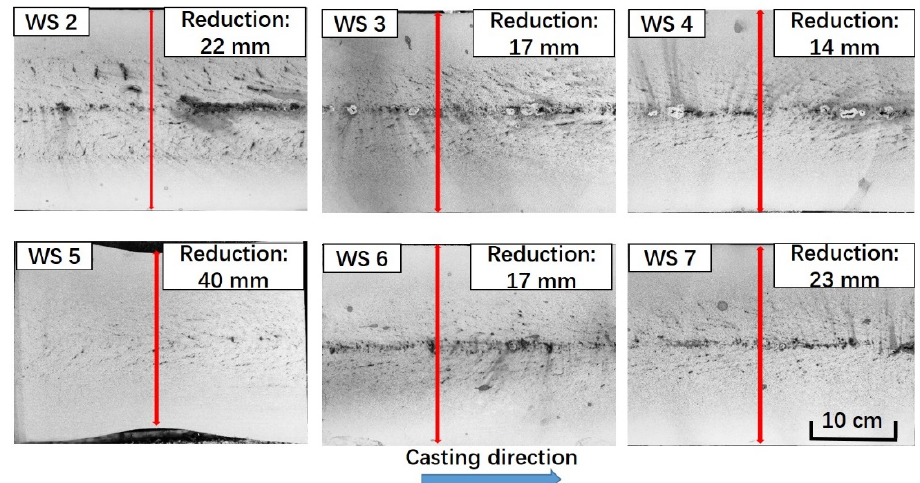
Figure 3. Hot etched photos of longitudinal section of the bearing steel blooms.